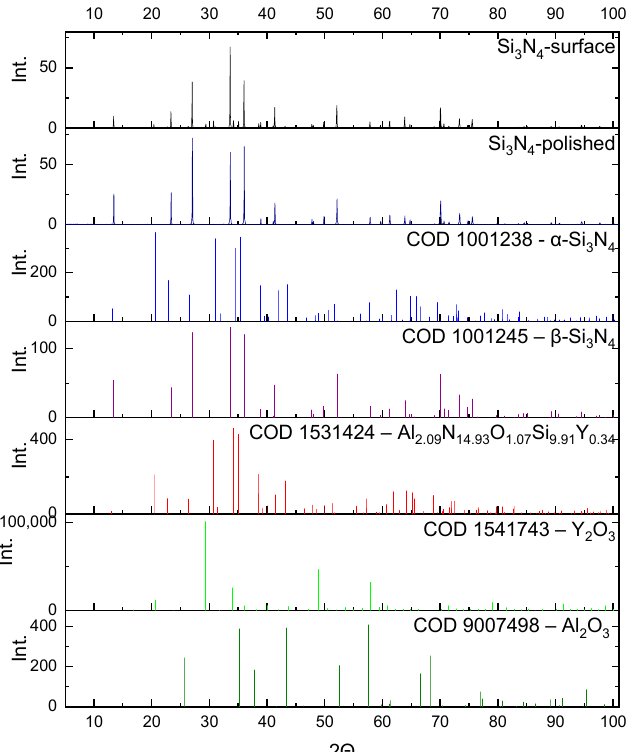
Figure 4. Diffractogram of the Si 3 N 4 material sintered at a temperature of 1800 °C (HIP) and the intensity of the characteristic reflections of the phases present in the sample.